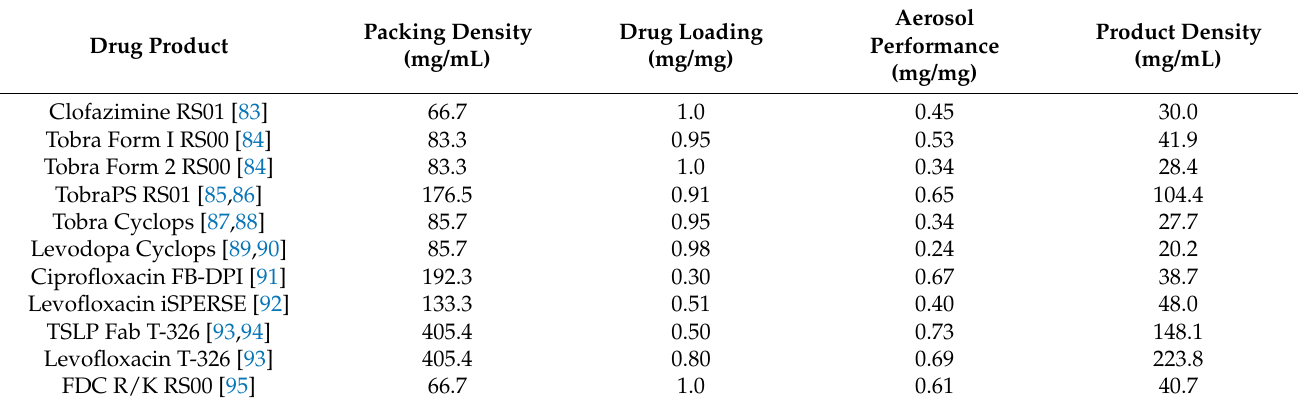
Table 2. Product densities from selected research